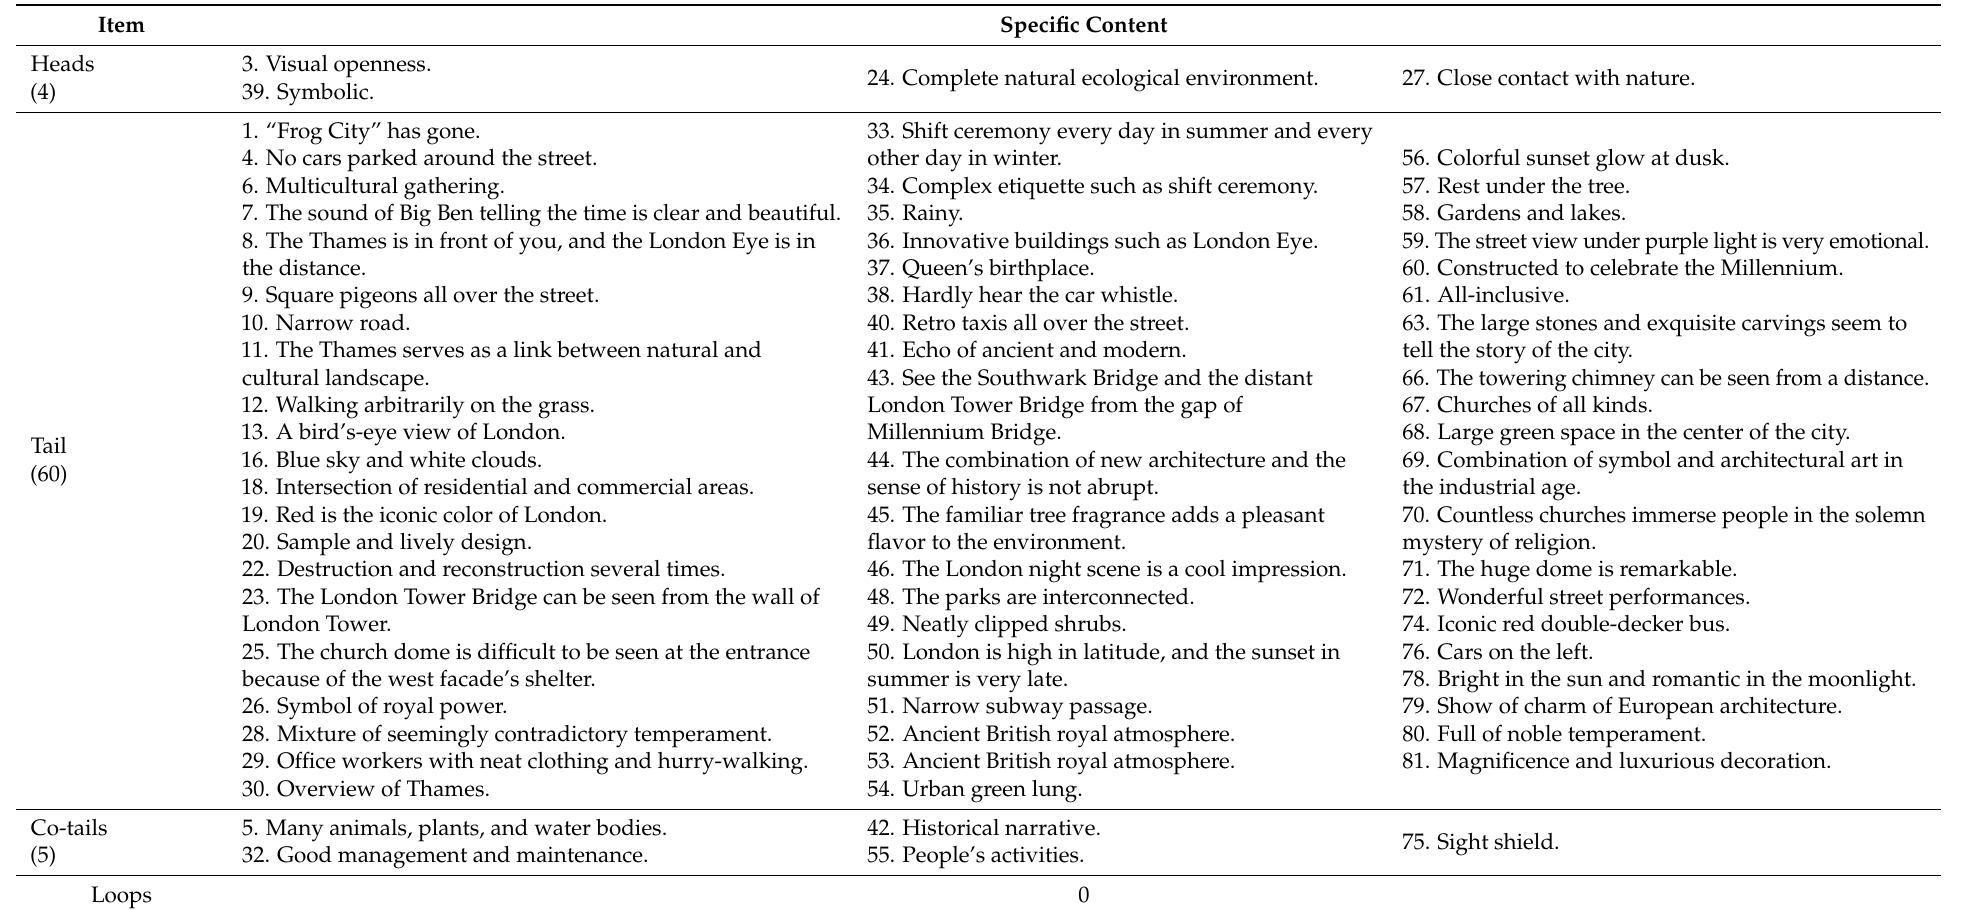
Table 1. Construction Types of Variables of Perception Phenomenon in Cognitive Map. (Total Number of Variables: